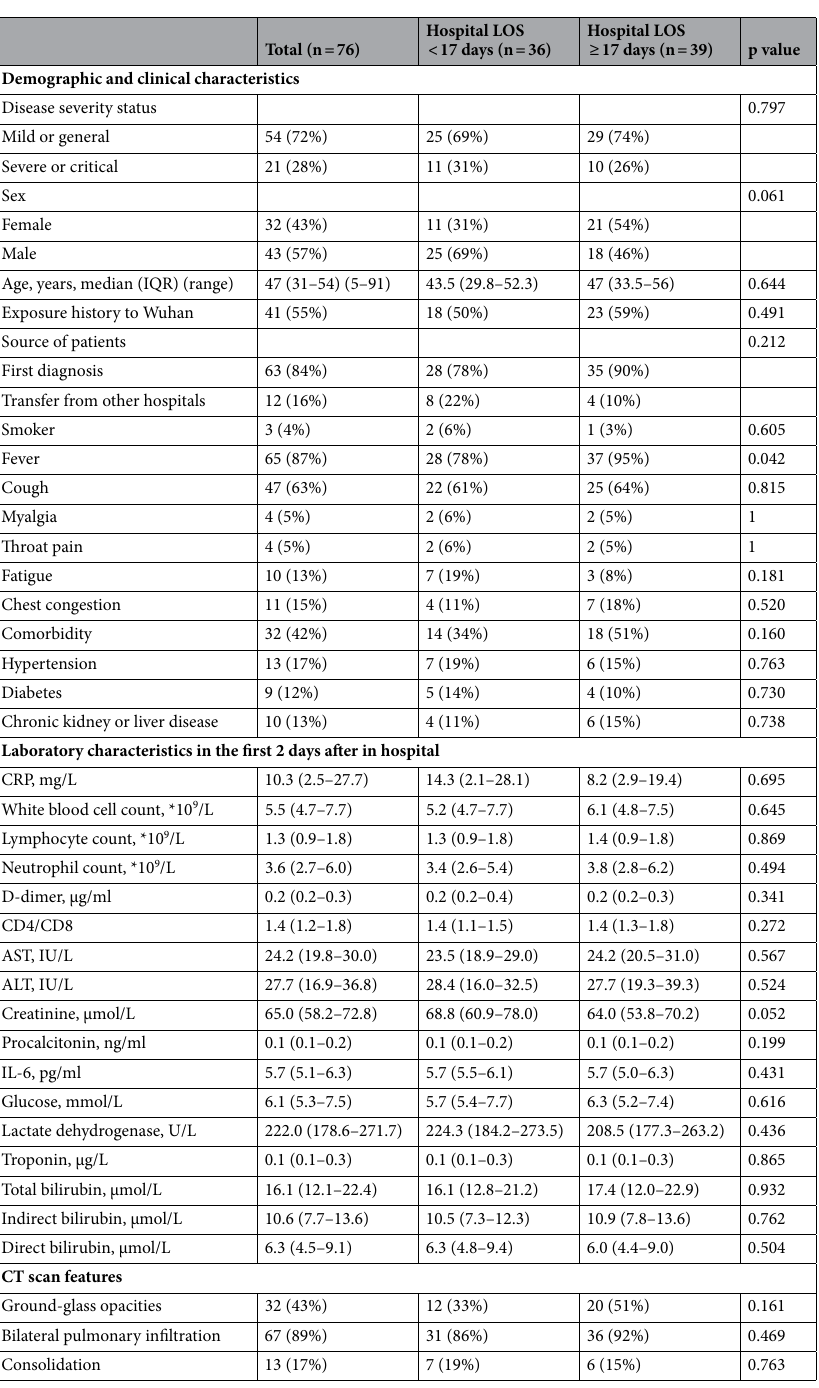
Table 1. Epidemiological, demographic, clinical and laboratory characteristics of COVID-19 patients by hospital length of stay (LOS). Data are median (IQR), or number (%). p values were calculated by Mann– Whitney U test or Fisher exact test, as appropriate. CRP C-reactive protein, IL-6 interleukin 6, AST aspartate aminotransferase, ALT alanine aminotransferase, IQR , inerquartile